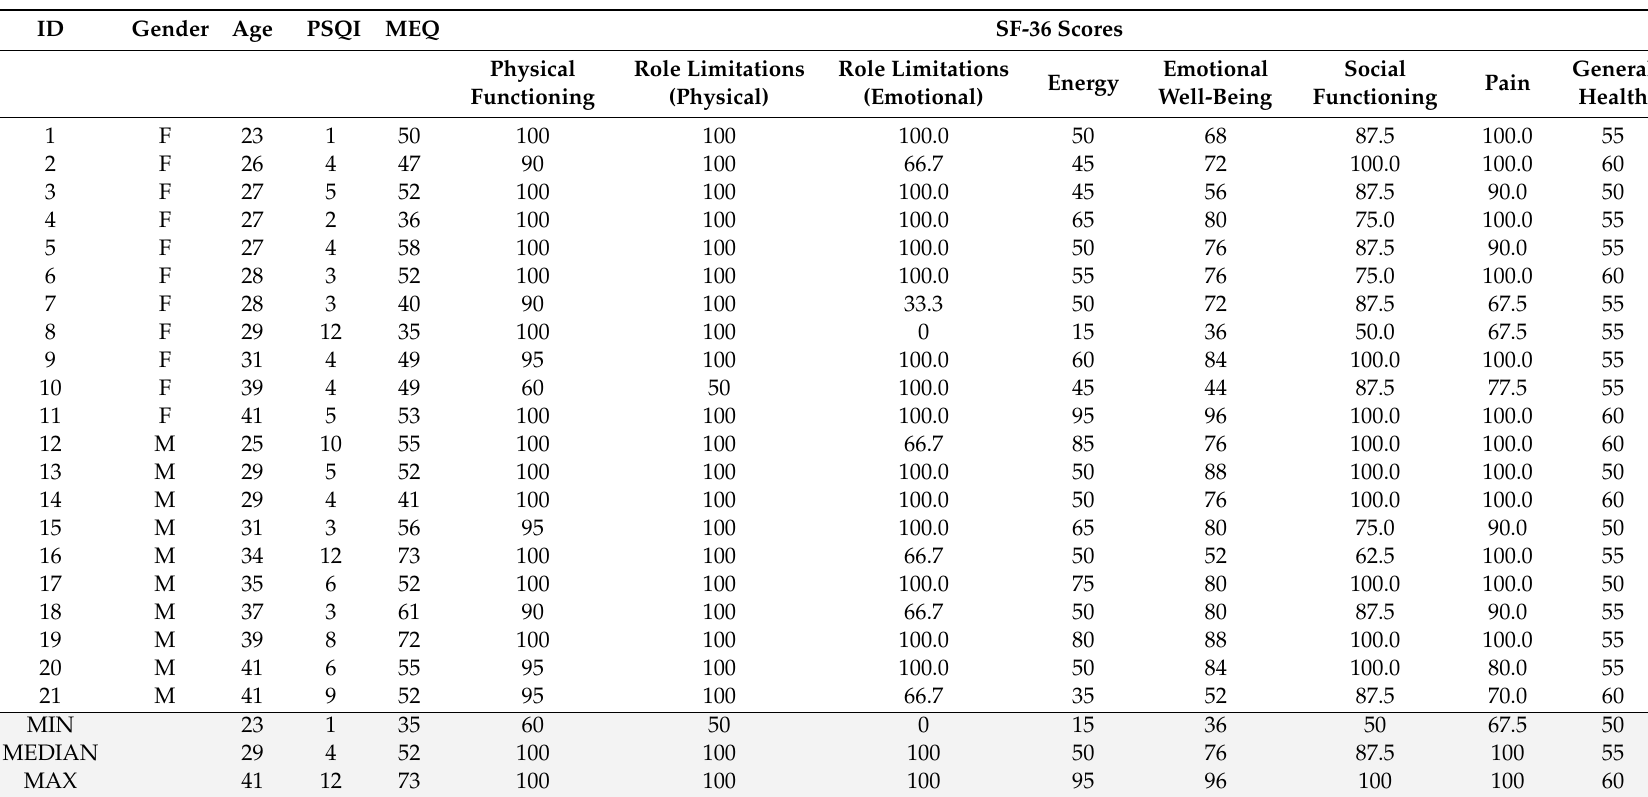
Table 1. Summary of the study population. The participant’s gender (M / F / O), baseline assessment of sleep quality according to the Pittsburgh Sleep Quality Index (PSQI) (with higher values indicative of poorer sleep), age, SF-36 score (a measure of general health along eight axes), and MEQ time (optimal time of day) are